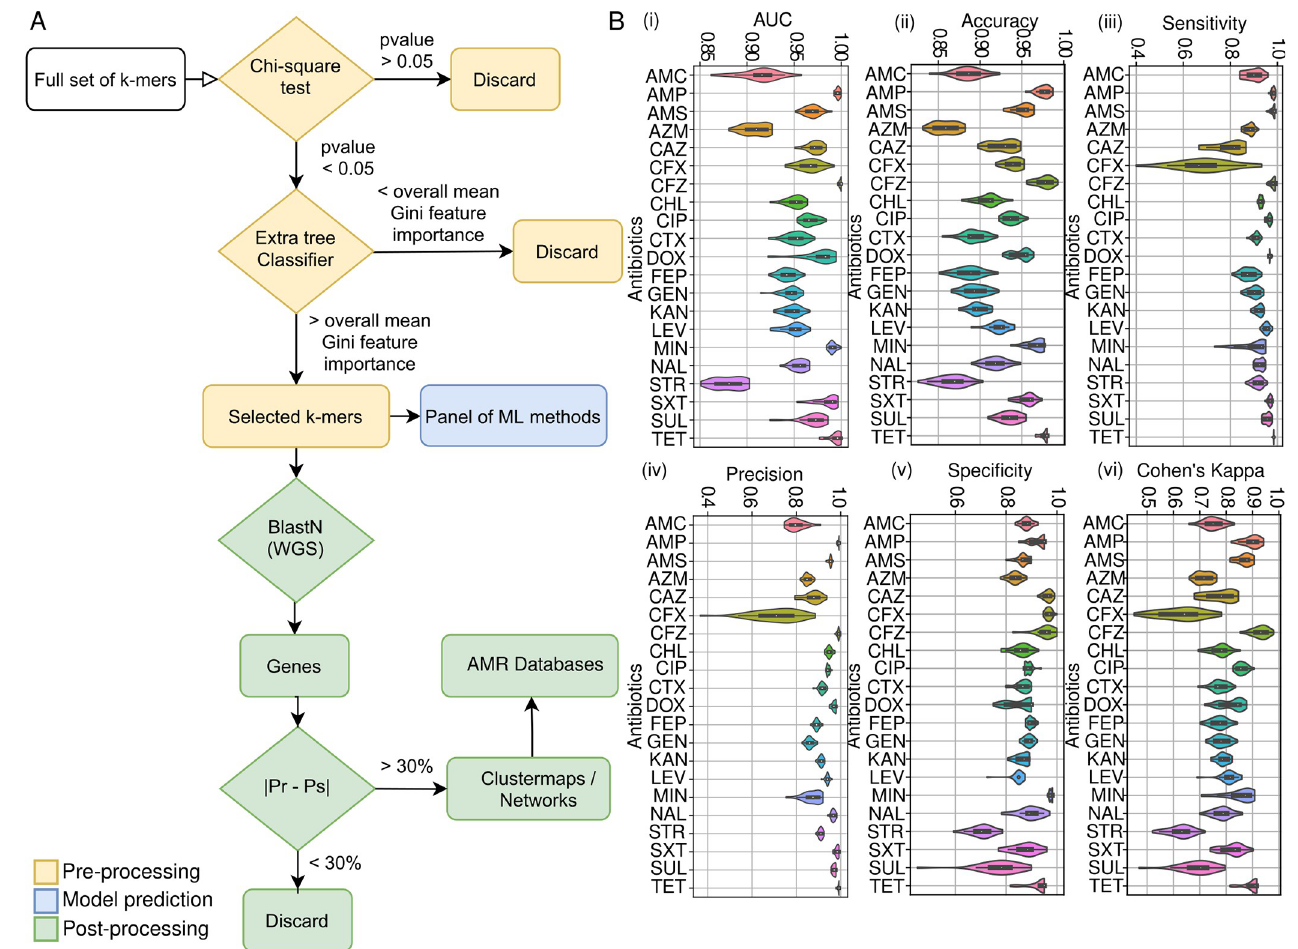
Fig 2. Supervised machine learning prediction of antimicrobial resistance signature profiles to 21 antimicrobials in the E . coli cohort. (A) Flow diagram showing the machine learning pipeline including feature selection (yellow), classification (blue), post-processing (green). (B) Prediction performance results of the RBF SVM classifier that achieved the best performance amongst the three investigated is shown. Five performance indicators have been used to evaluate the classification: i) Area under the curve AUC, ii) Accuracy, iii) Sensitivity, iv) Precision, v) Specificity, and vi) Cohen’s Kappa value from 30 training runs for each antimicrobial. The scores for each performance metric are indicated in the Y axis. Predictive models were generated to classify the resistance vs. susceptibility profiles of twenty-one different antimicrobials (X axis): amoxycillin/clavulanic acid (AMC), ampicillin (AMP), ampicillin/sulbactam (AMS), aztreonam (AZM), ceftazidime (CAZ), cefoxitin (CFX), cefazolin (CFZ), chloramphenicol (CHL), ciprofloxacin (CIP), cefotaxime (CTX), doxycycline (DOX), cefepime (FEP), gentamicin (GEN), kanamycin (KAN), levofloxacin (LEV), minocycline (MIN), nalidixic acid (NAL), streptomycin (STR), trimethoprim/ sulfamethoxazole (SXT), sulfisoxazole (SUL) and tetracycline